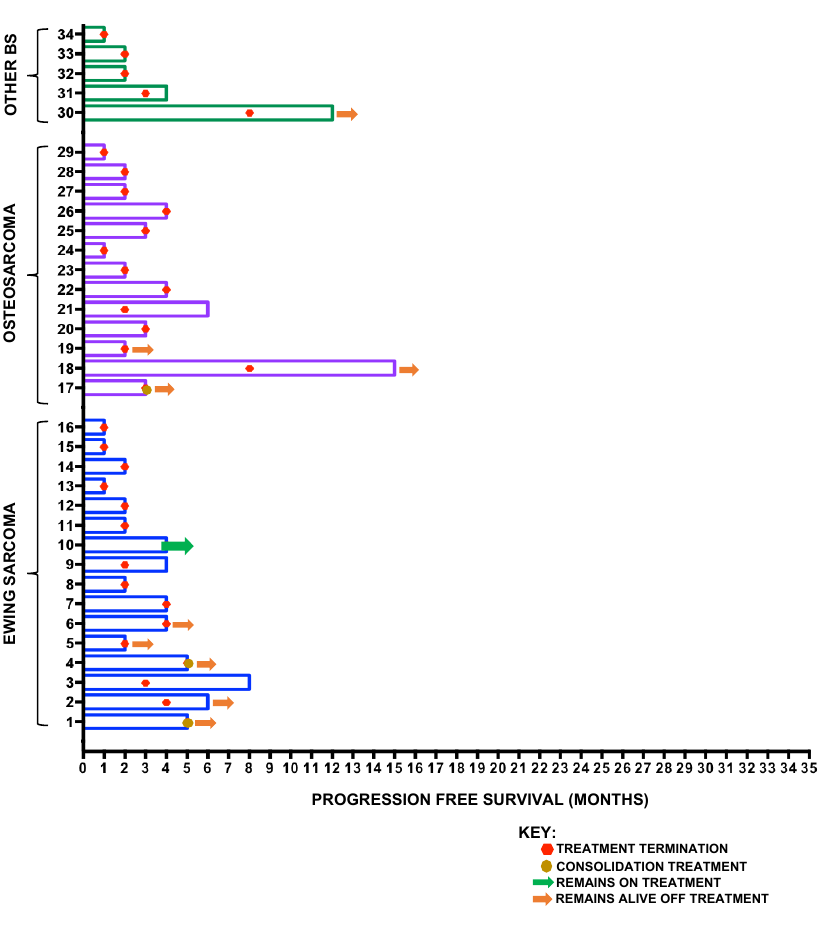
Figure 5. Swimmer plot of BS cohort demonstrating PFS and timing of treatment termination, along with details of their current status at the time of analysis.